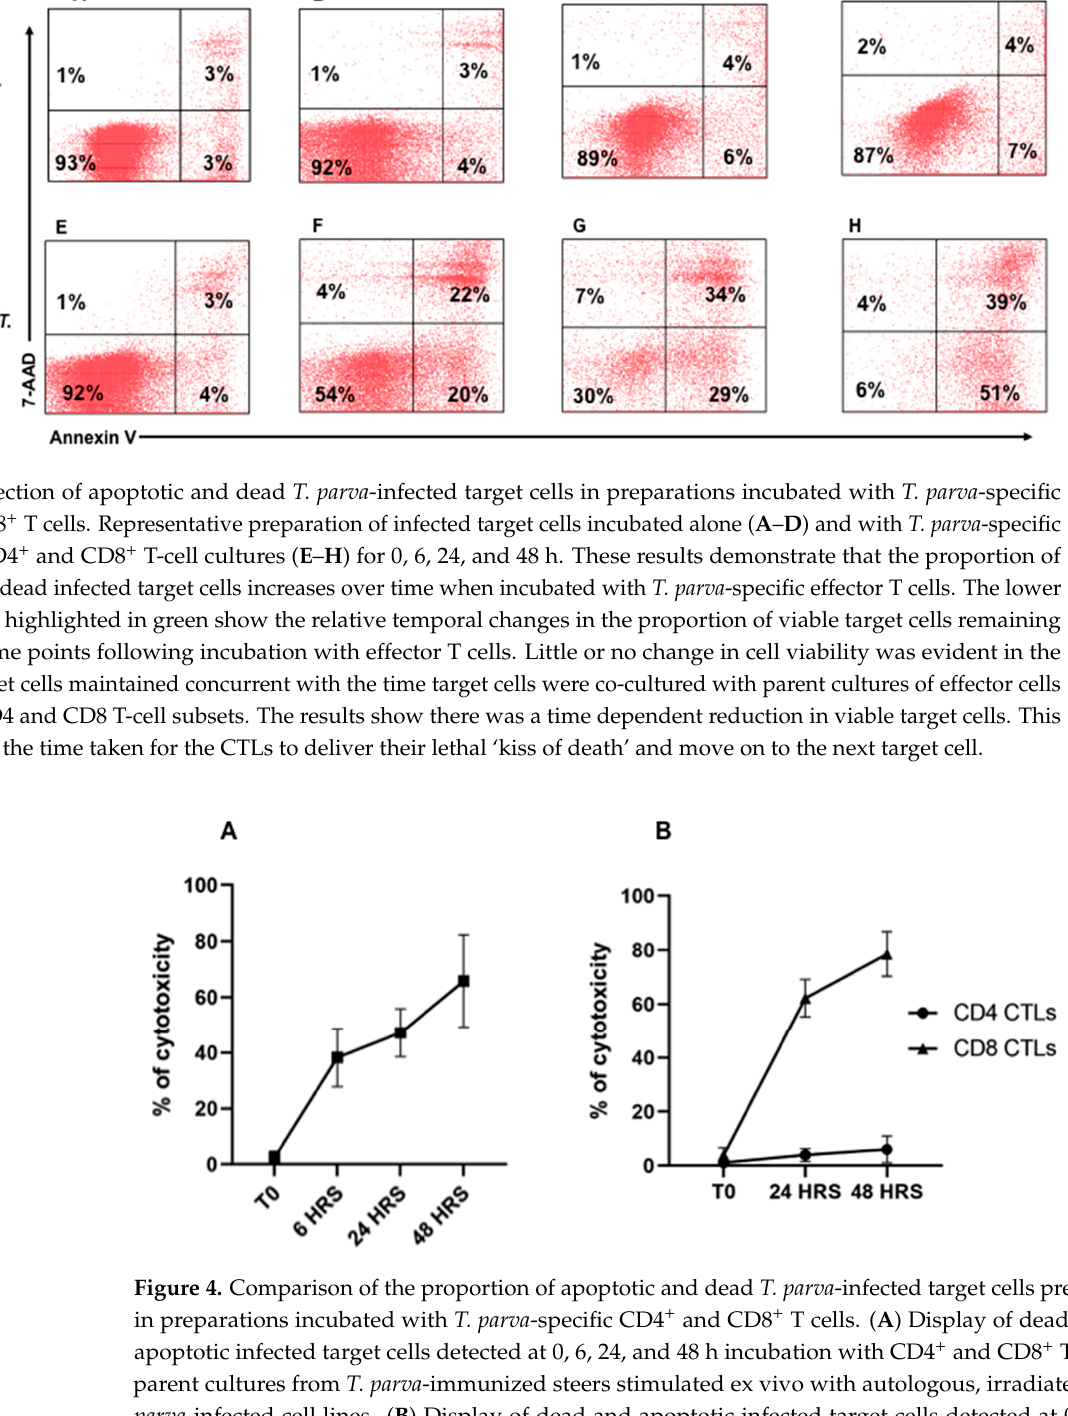
Vet. Sci. 2021 , 8 , x FOR PEER REVIEW 7 of 13 previously described [26]. Analysis of data obtained from comparison of CTL activity from all four immunized steers revealed a significant increase in the mean percentages of